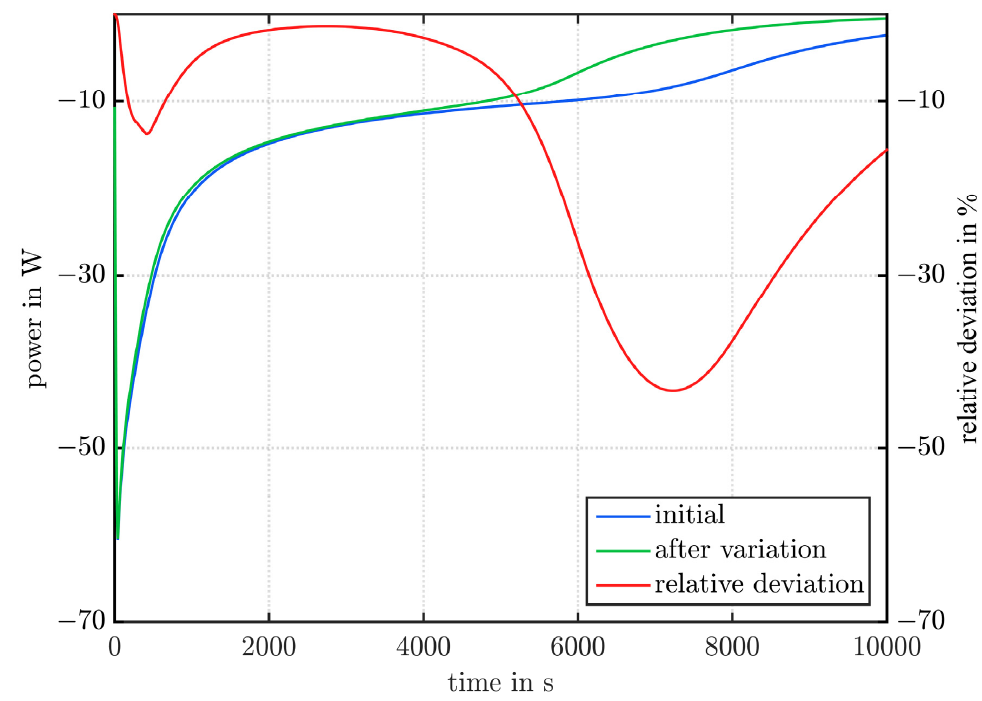
Figure A4. Power over time curve for discharging of the standard case and the case with heat losses as well as the regarding relative deviation. Appl. Sci. 2019 , 9 , x FOR PEER REVIEW